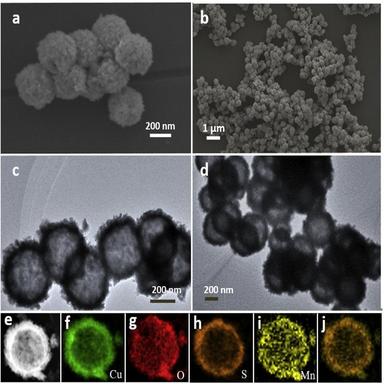
(a,b) SEM and (c,d) TEM images Cu2O@Cu9S5@MnO2; (e) STEM and corresponding EELS element maps of (f)Cu, (g)O, (h)S, (i) Mn and (j)the overlapping map of S and Mn of Cu2O@Cu9S5@MnO2.